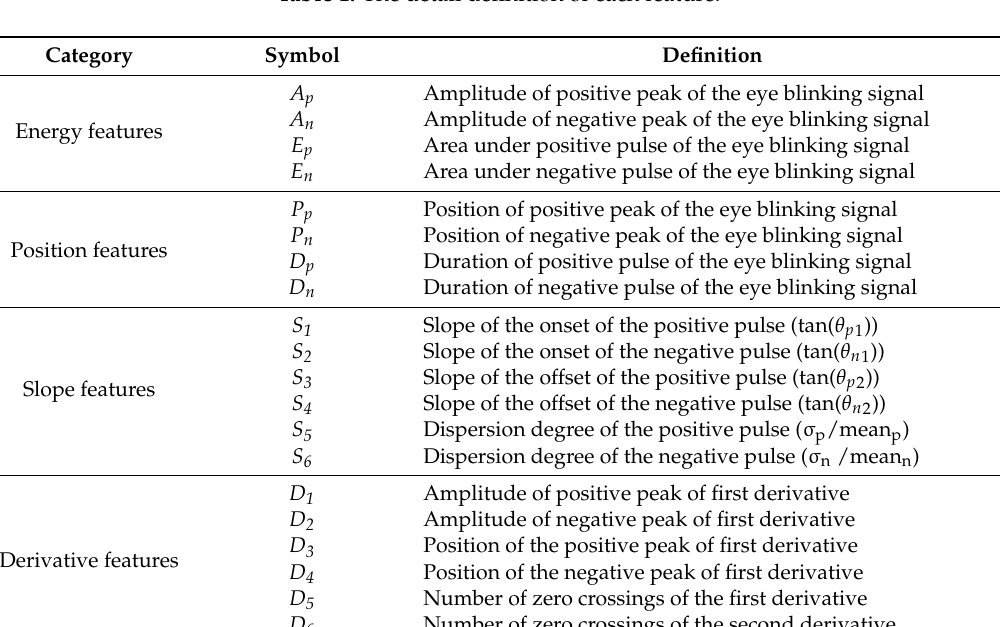
Figure 9. Time domain morphological features of the eye blinking signals. Table 1. The detail definition of each